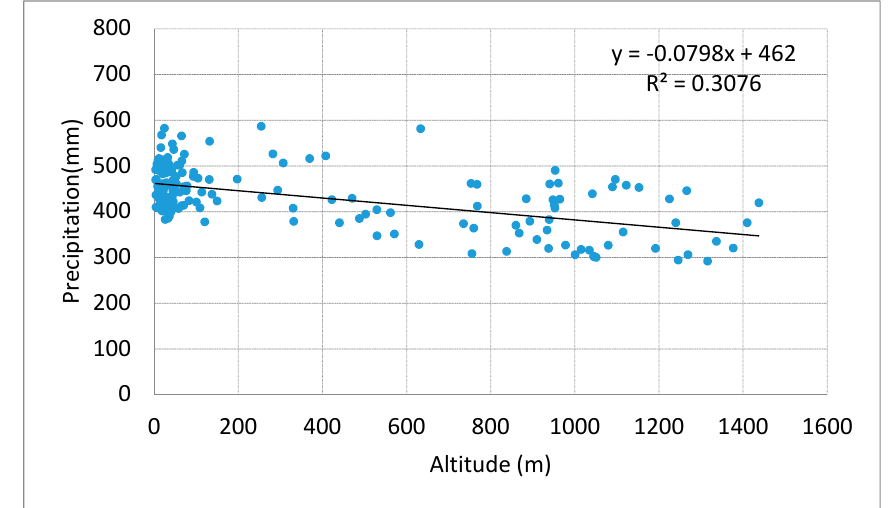
Figure 13. The relationship between warm-season precipitation of non-city stations and their altitudes in the Haihe River basin, 2007–2017.